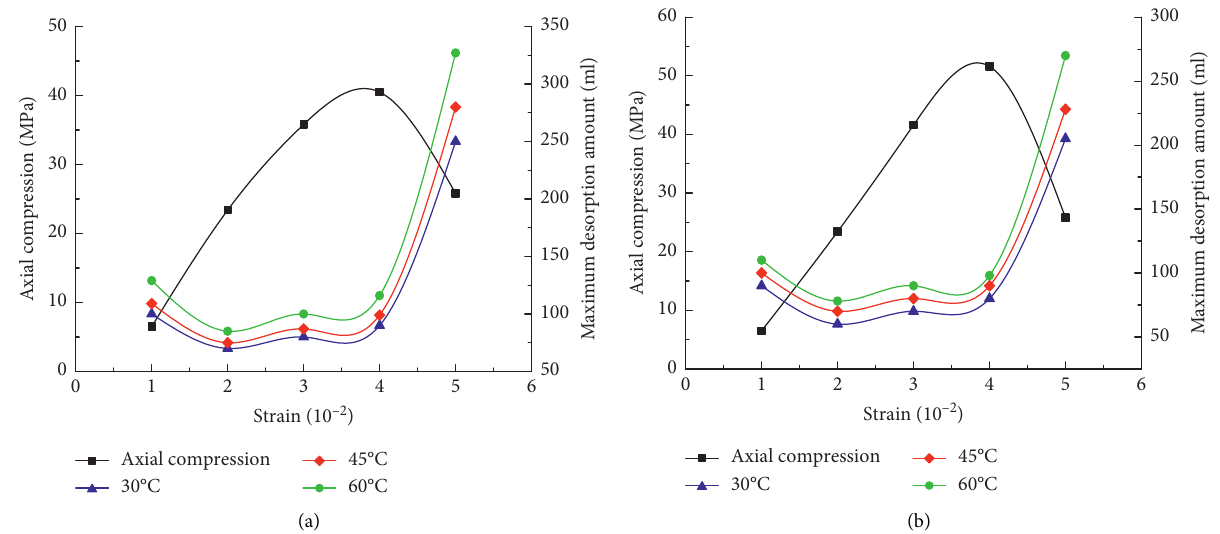
Figure 11: Relation curve between stress-strain and desorption amount under the confining pressure of (a) 3MPa and (b) 5MPa.